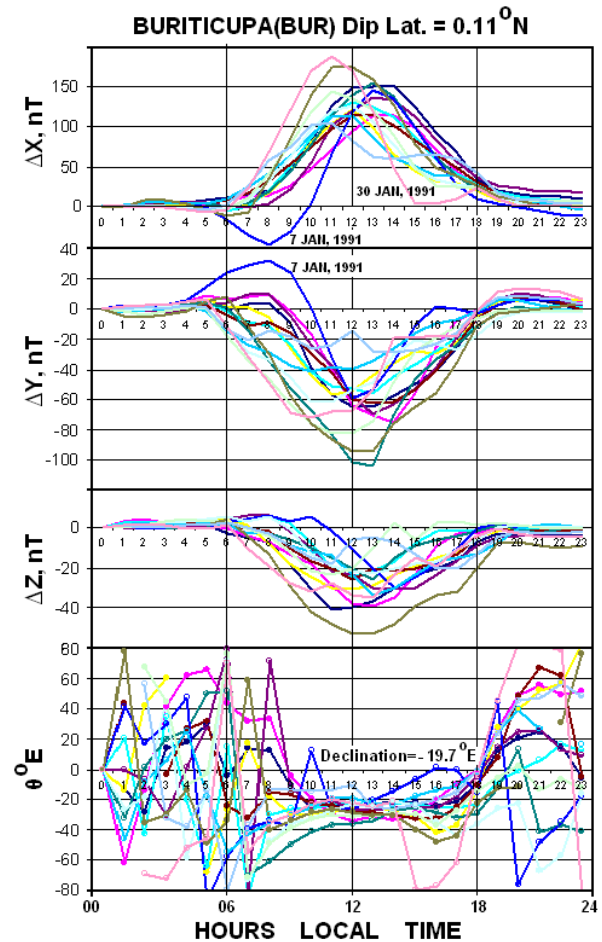
Fig. 4a. Overlapping plots of the daily variation of 1X , 1Y , 1Z and θ direction of H east of geographic north = arc tan ( 1 DY/ 1 DX) on all days for